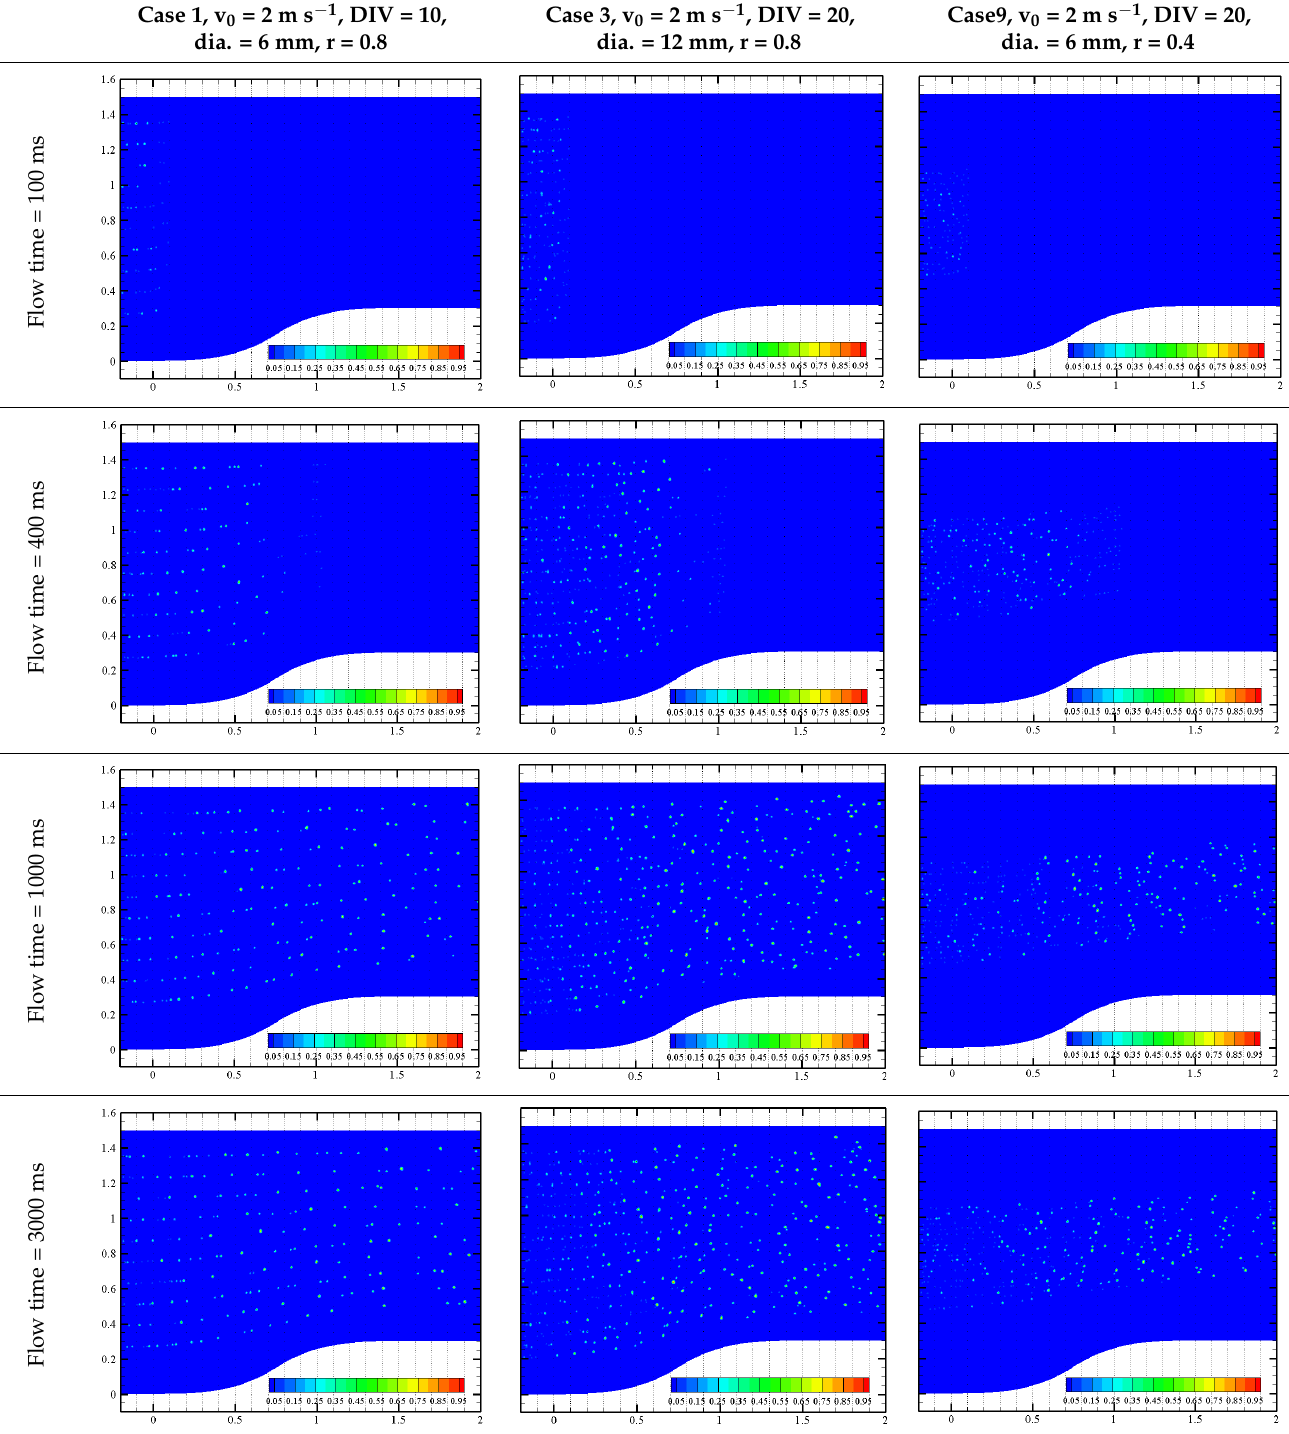
Table 2. Phase distribution in the contraction section under three different flow parameters.